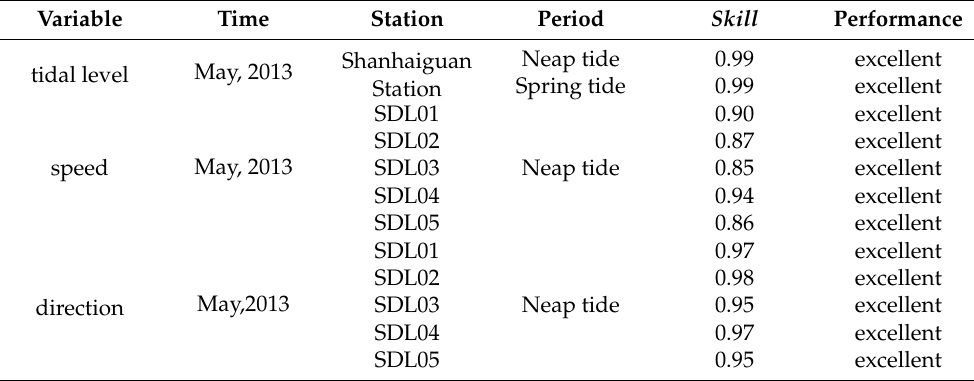
Figure 3. Model validation of tidal level and current velocity. Table 1. Hydrodynamic model evaluation.